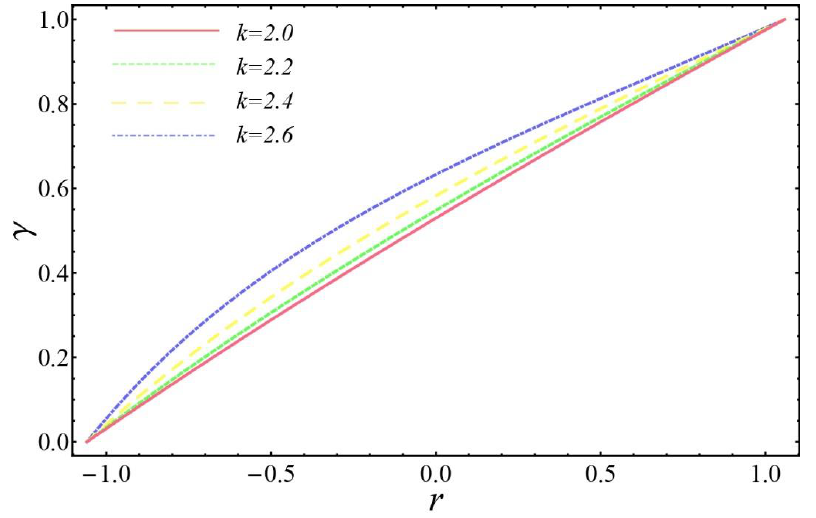
Figure 10. Alteration of k on γ when 𝑥 = 0.1; 𝑡 = 0; 𝑄 = 10; 𝛽 = 0.2; 𝜖 = 0.1; 𝑁 𝑏 = 2; 𝑁 𝑑 = 1; 𝐿 𝑑 = 0.1.